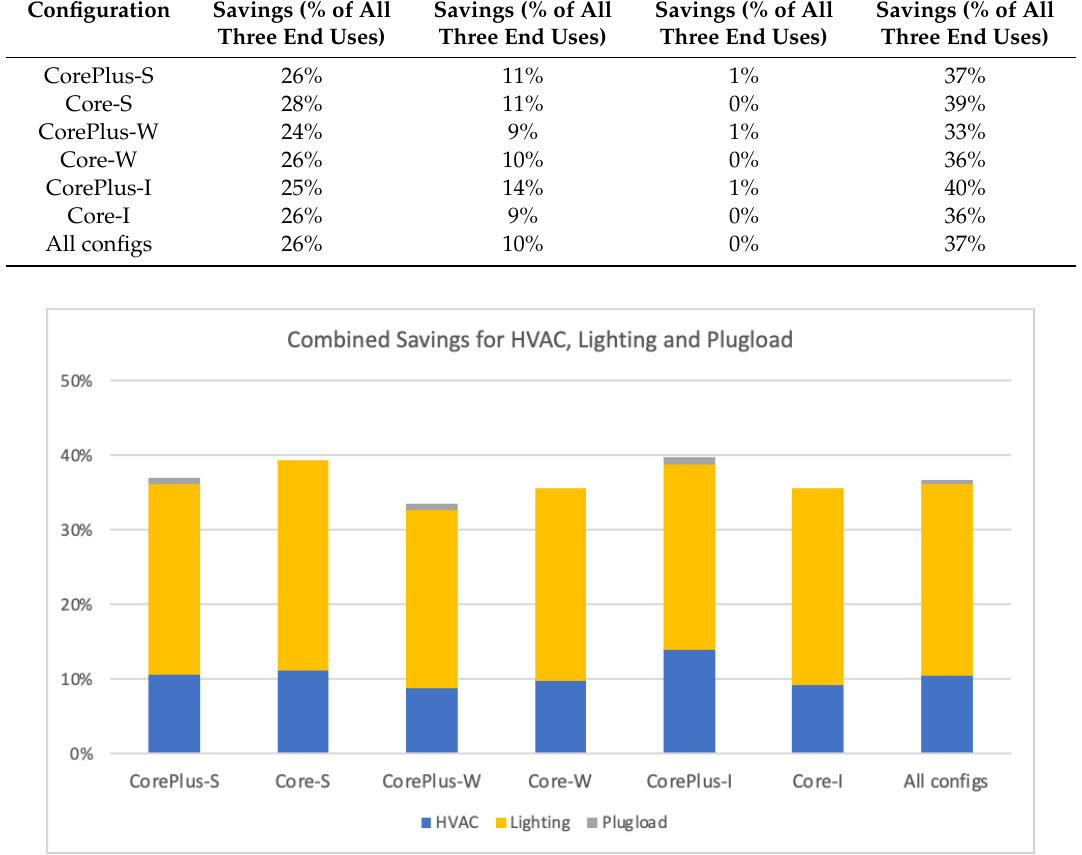
Figure 13. Combined savings breakout for HVAC, lighting and plug loads.